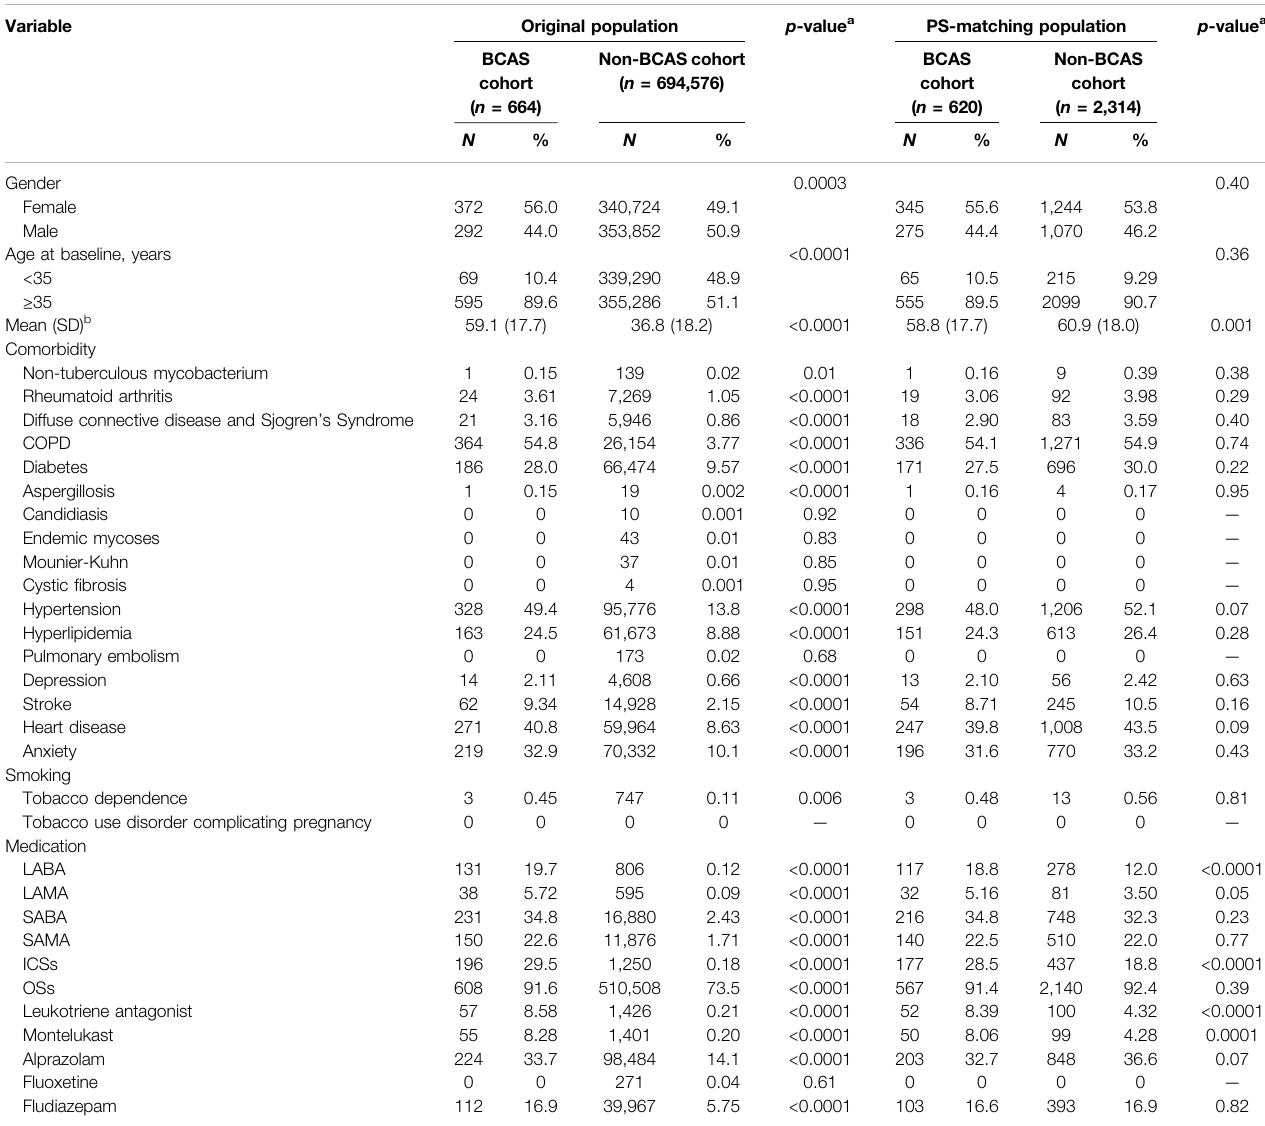
TABLE 1 | Baseline characteristics of study population.